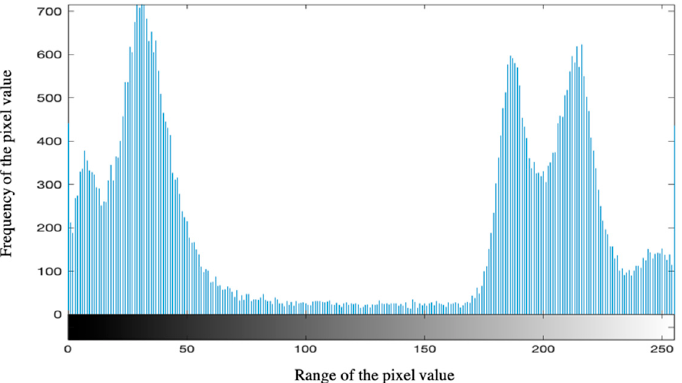
Figure 4. An illustration of histogram graph for a COVID-19 patient CT scan image.